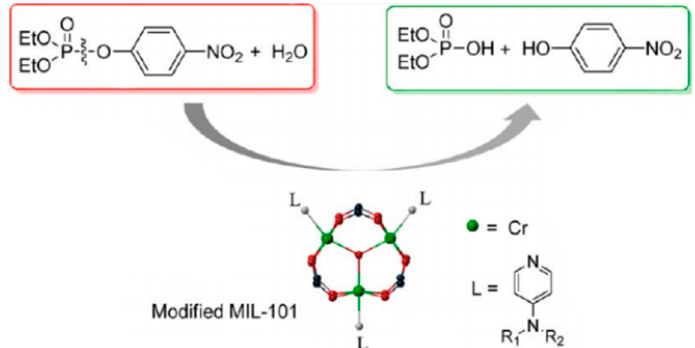
Figure 27. MIL-101 with chelated aminopyridines as a catalyst for organophosphorus ester degradation. (Reprinted with permission from [197]. Copyright © 2013, American Chemical Society).